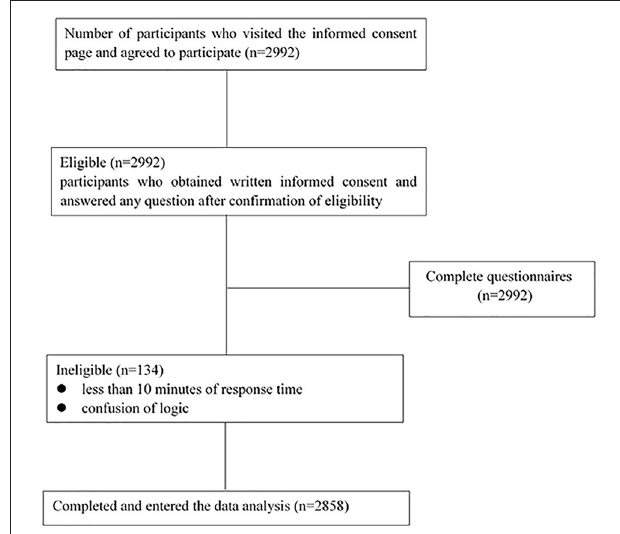
FIGURE 1 | Flowchart of participant inclusion, exclusion, and completeness of